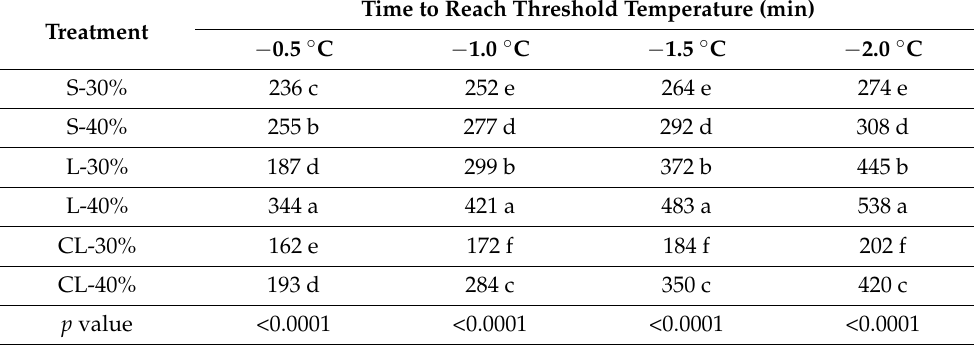
Table 2. Time (in minutes) it took for each treatment (soil type x moisture content) to reach defined threshold values of − 0.5 ◦ C, − 1.0 ◦ C, − 1.5 ◦ C, or − 2.0 ◦ C from a chamber ambient temperature of 15 ◦ C. Moisture content refers to 30% or 40% of water holding capacity. Mean comparison